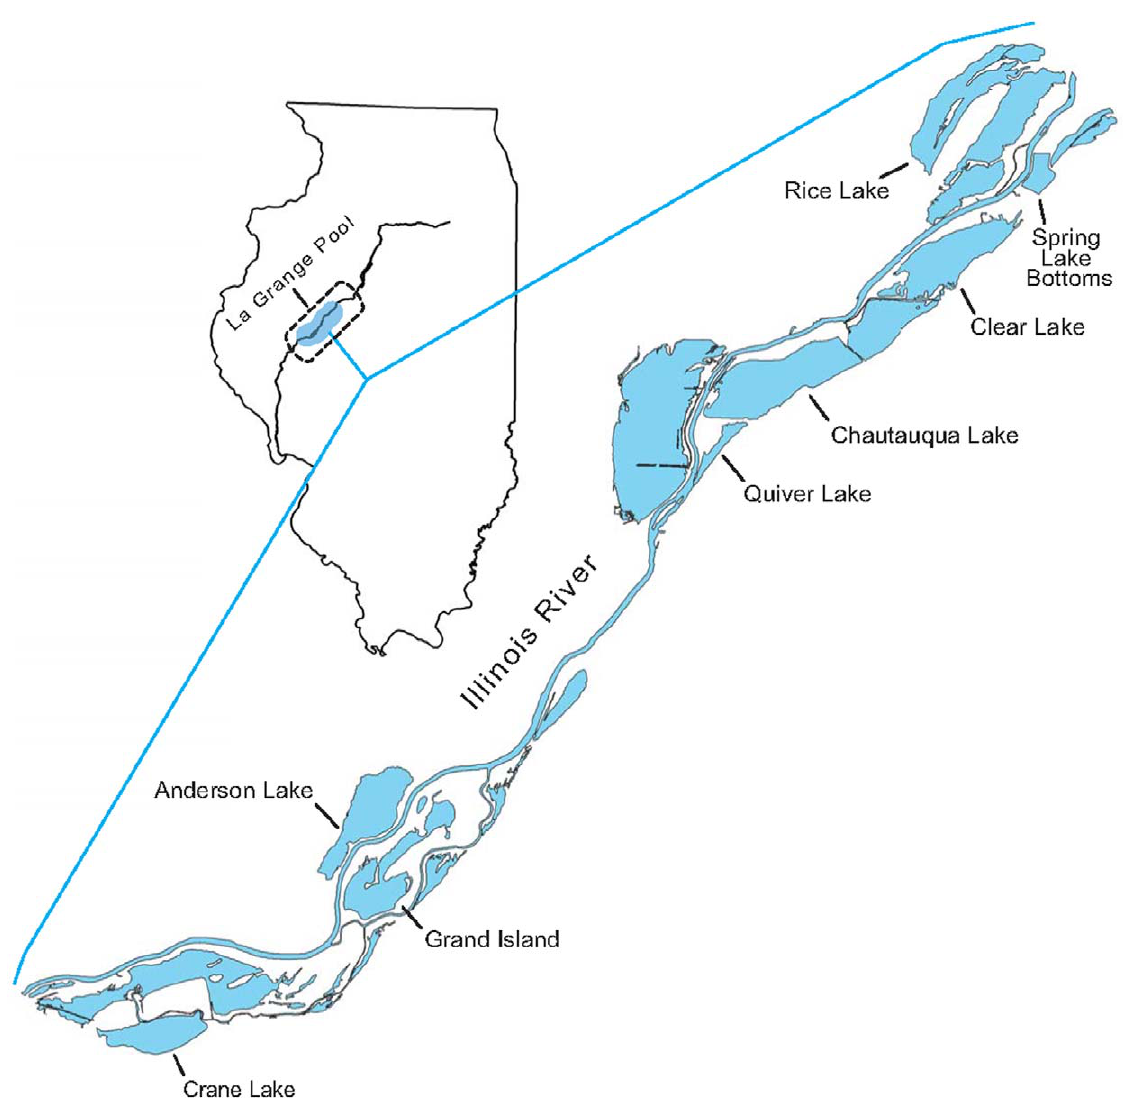
Figure 1. Map depicting our study area within La Grange Pool (dotted line) of the Illinois River in central Illinois, and specific study wetlands (labeled).